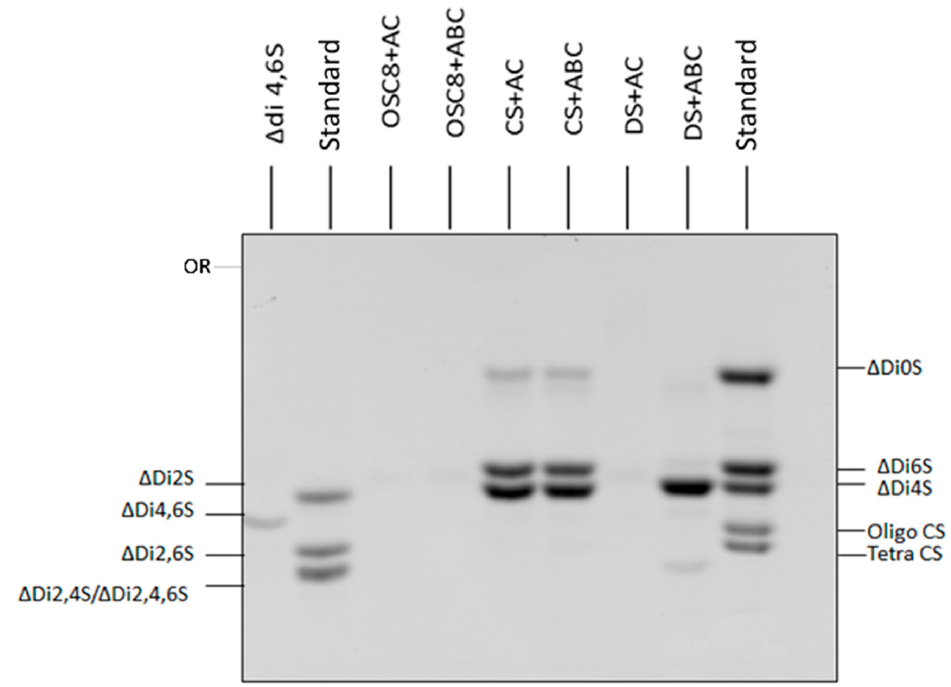
Figure 8. Analysis by Fluorophore Assisted Carbohydrate Electrophoresis (FACE) of the products formed from OSC8 by the exhaustive degradation with Chondroitinases AC and ABC. The structural characteristics of the OSC8 were investigated by degradation with chondroitinases AC and ABC under exhaustive degradation conditions (72 h and 0.3 enzyme units). The products formed were derivatized with AMAC and analyzed by polyacrylamide gel electrophoresis in Tris Borate pH 8.3 bu ff er, and displayed by UV light absorption, as described in Methods. OSC8 is not a substrate for the enzymes, since no products could be detected by this methodology that enhances the detection of products. ∆ Di2S: unsaturated 2-sulfated disaccharide; ∆ Di4S: unsaturated 4-sulfated